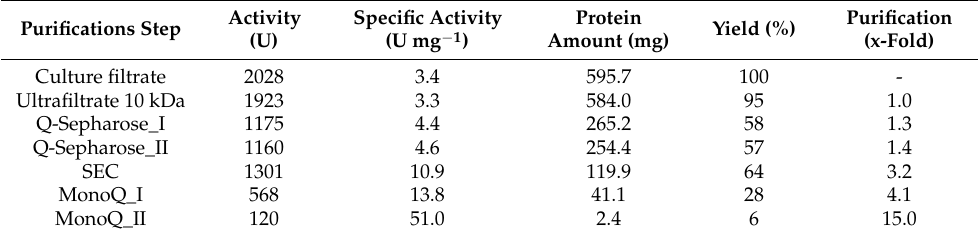
Table 1. Purification of the extracellular peroxidase from X. grammica ( Xgr DyP). Purifications